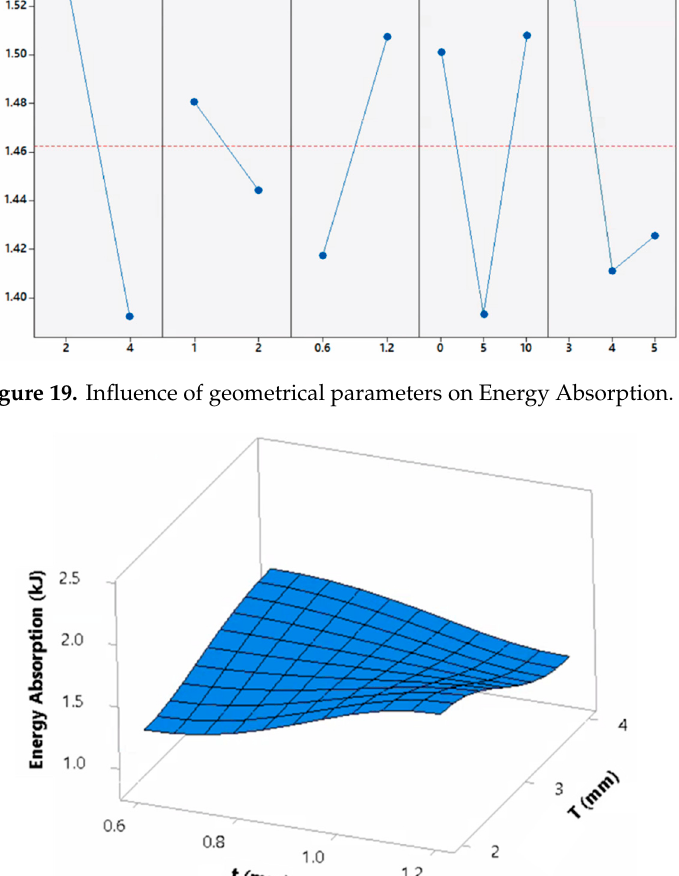
Figure 20. Dependence of Energy Absorption on the interaction of top-plate and tube thicknesses.